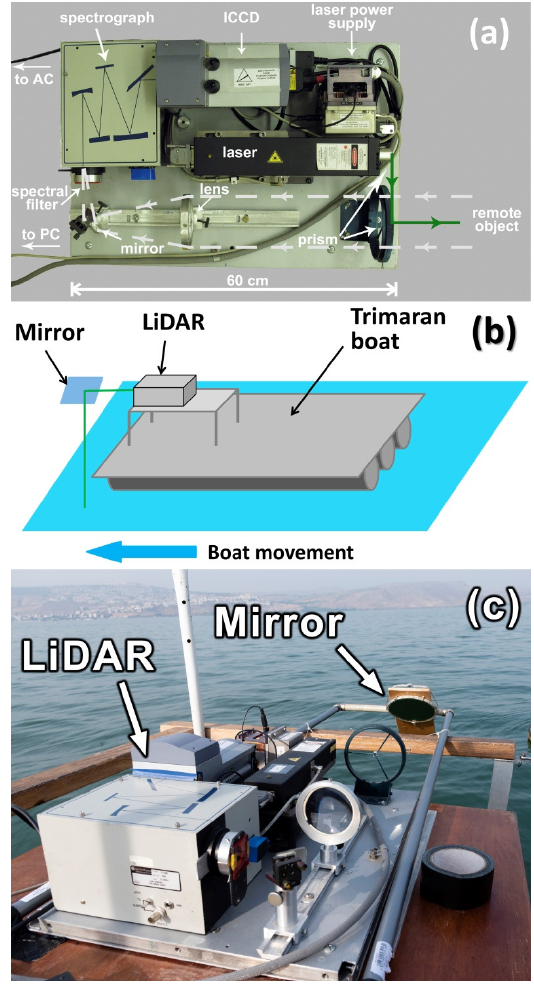
Figure 3. ( a ) Top view of the compact fluorescence LiDAR; ( b ) scheme of the LiDAR sensing; ( c ) photo of the LiDAR installed on the